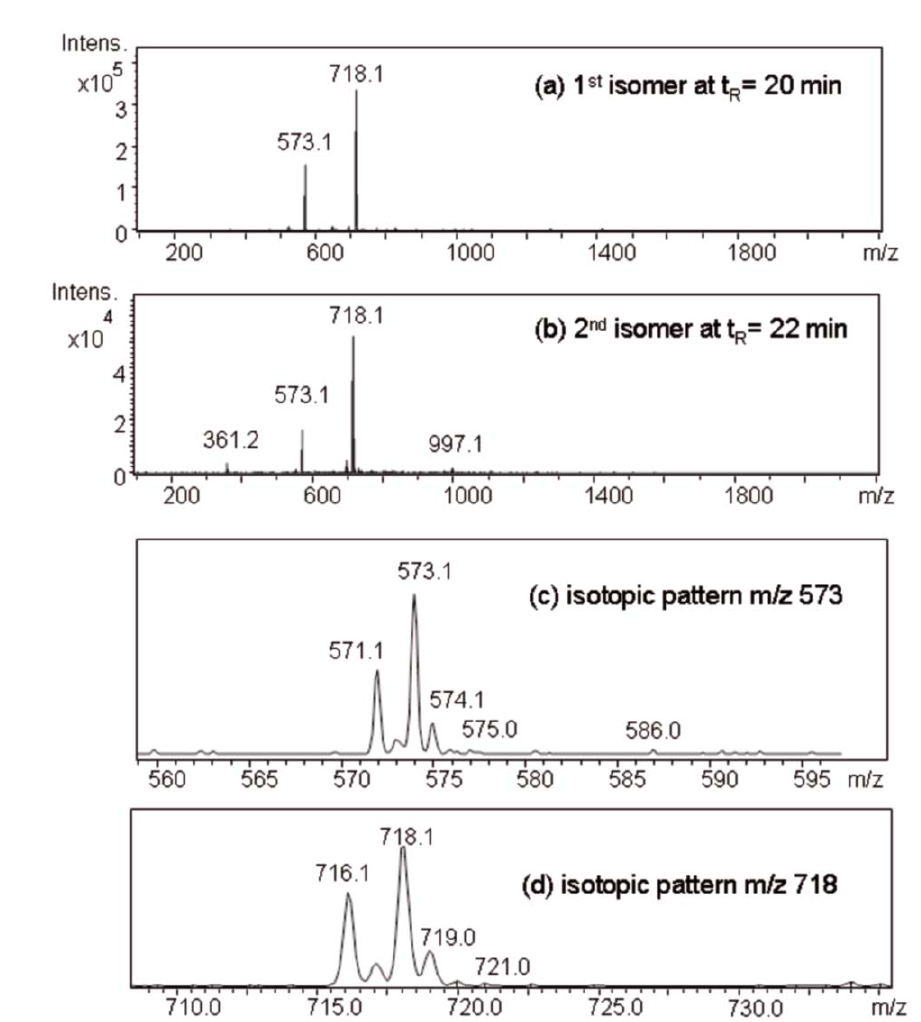
Figure 4. MS spectra of (a) 1st isomer peak at t with 718 m/z and 573 m/z